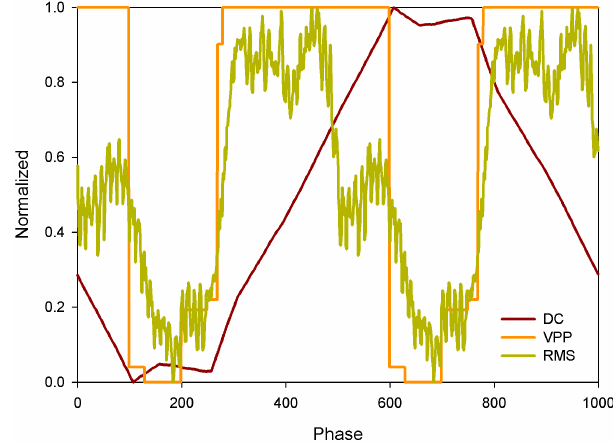
Figure 9. Evaluated functions of direct current (DC) value, peak- to-peak voltage Vpp and effective root mean square (rms) of the mask-convoluted